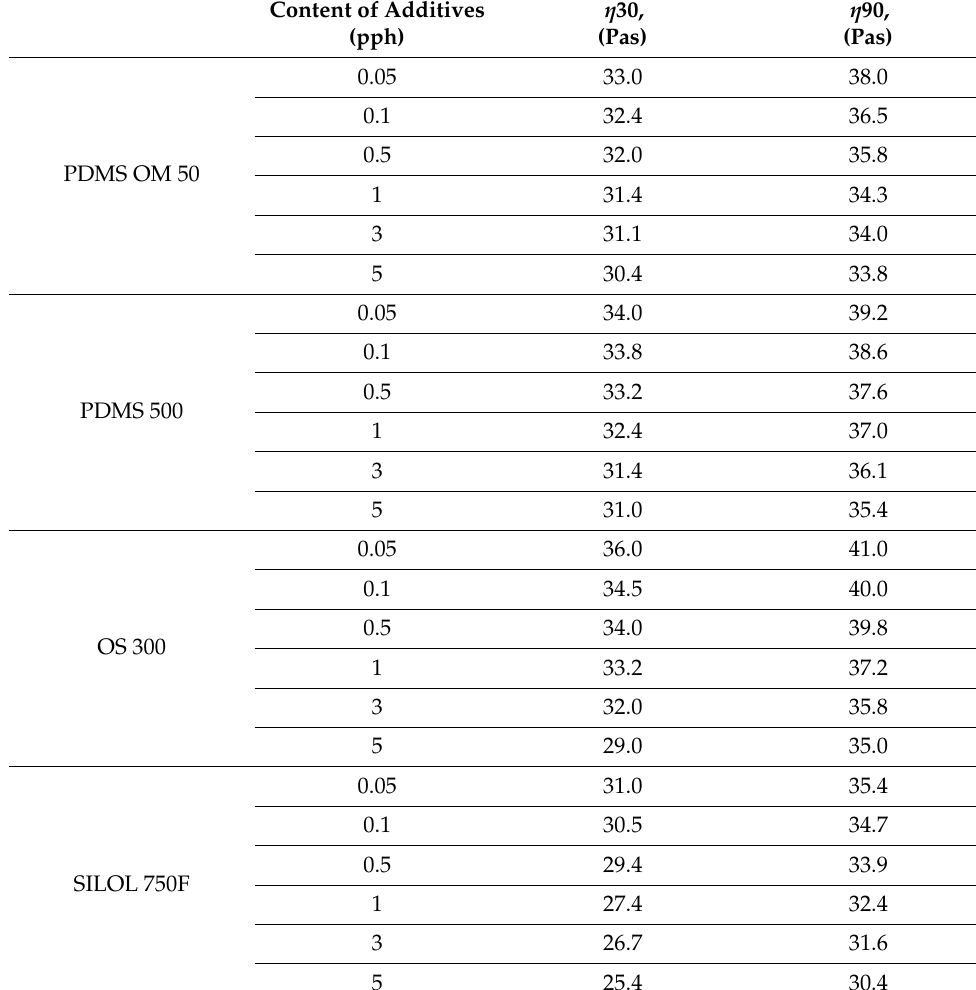
Table 5. Viscosity of pressure-sensitive adhesives after 30 and 90